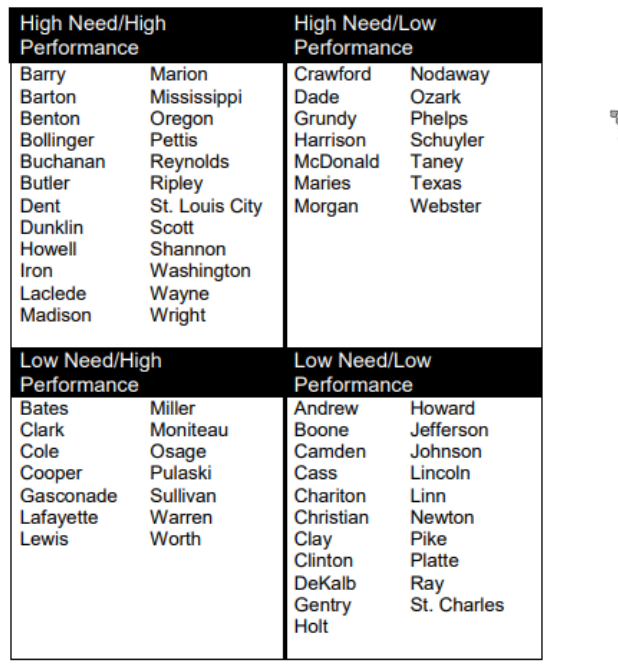
Figure 4. Need vs. Performance